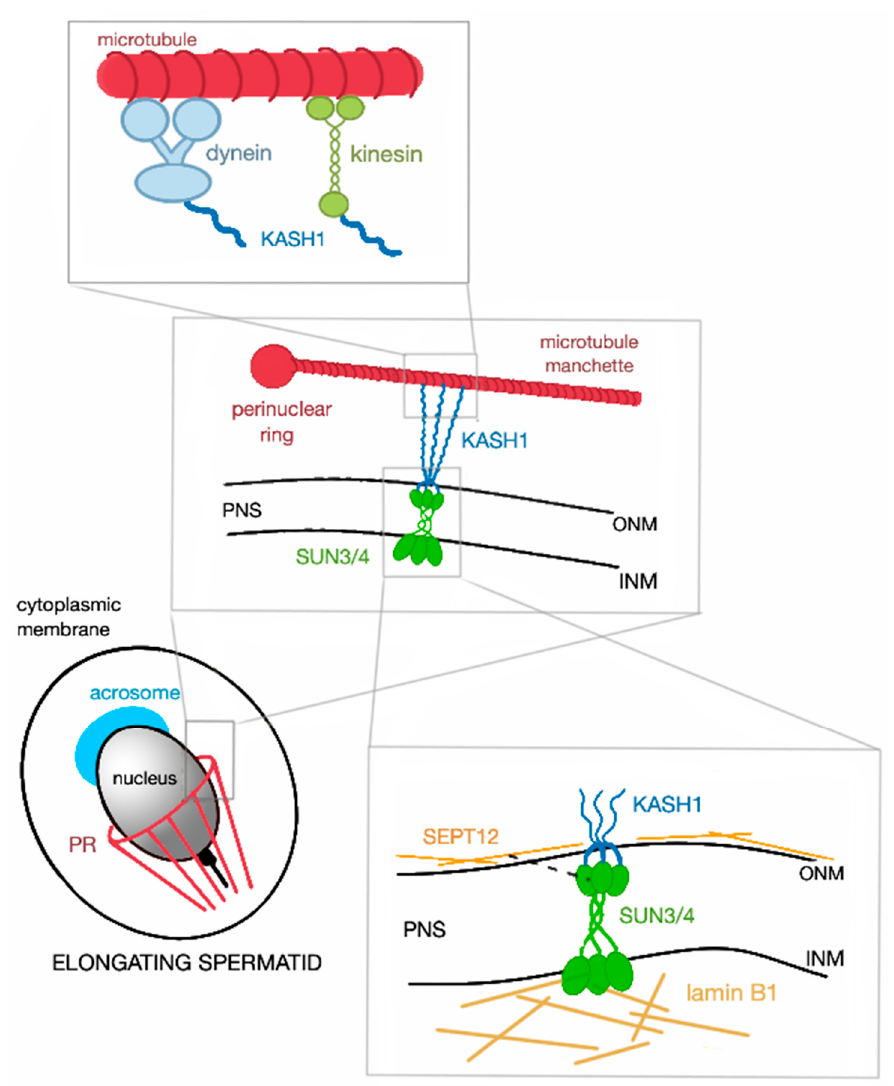
Figure 2. Schematic representation of SUN3 / 4:KASH1 LINC complex and its connection to the nucleoskeleton and cytoskeleton. In cytoplasm, KASH1 tethers the microtubule manchette to NE thanks to its ability to bind to subunits of kinesin and dynein, that can move alongside the microtubules. The nucleoplasmic part of the LINC complex, SUN3 / 4, is connected to lamin B1 and also associates with SEPT12 (represented by the black broken line, PR—perinuclear ring). KASH1 is a large KASH domain protein with a molecular weight of approximately 1000 kDa.